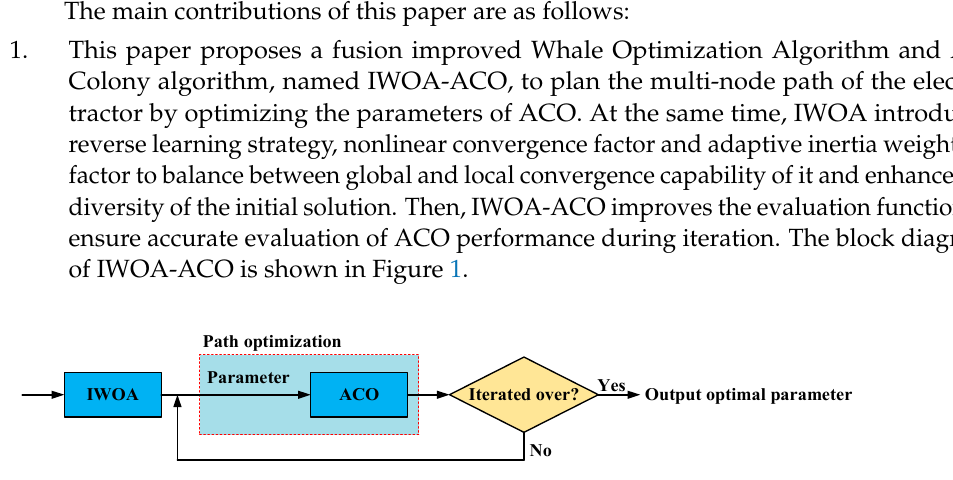
Figure 1. The block diagram of IWOA-ACO.